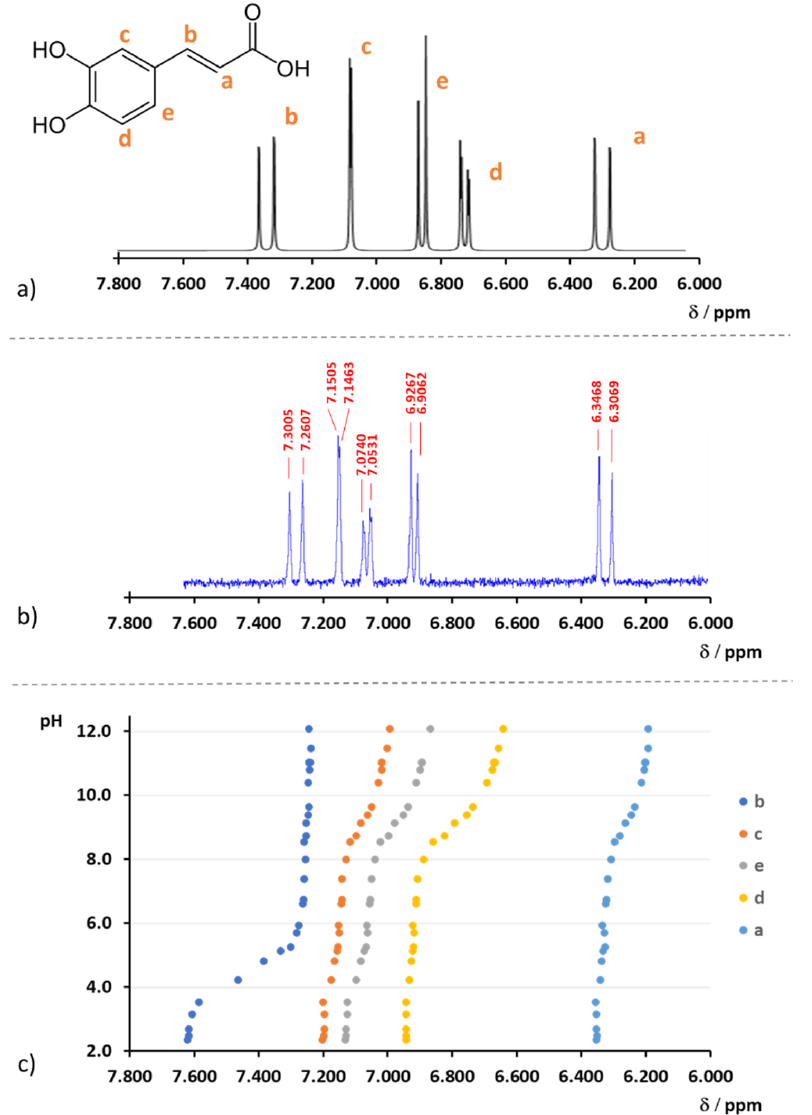
Figure 4. Representation of 1 H-NMR titration: ( a ) 1 H-NMR spectra of CFA calculated by ChemDraw software and corresponding peak attribution; ( b ) experimental 1 H-NMR spectra of CFA ( c CFA = 10 − 3 mol · dm − 3 , pH = 5.7); ( c ) representation of the chemical shifts of each assigned peak obtained from experimental spectra recorded at different pH Table 4. Calculated chemical shift ( δ /ppm) of different (de)protonated species of CFA, in KCl (aq) at I = 0.2 mol ∙ dm − 3 and T = 298.15 K.